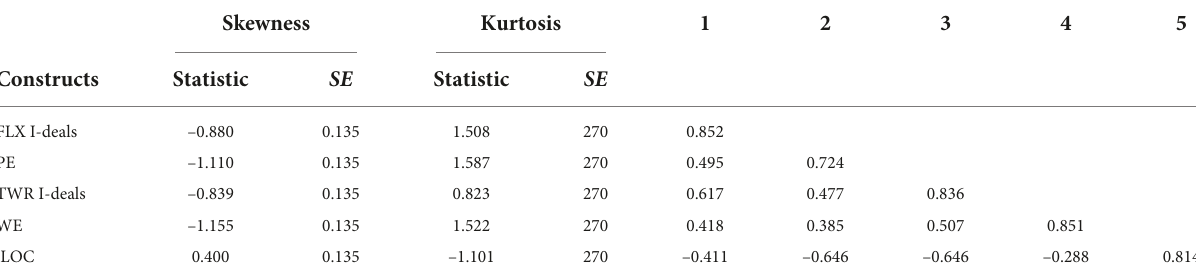
TABLE 1 Test of normality and Fornell–Larcker criterion ( N = 324).